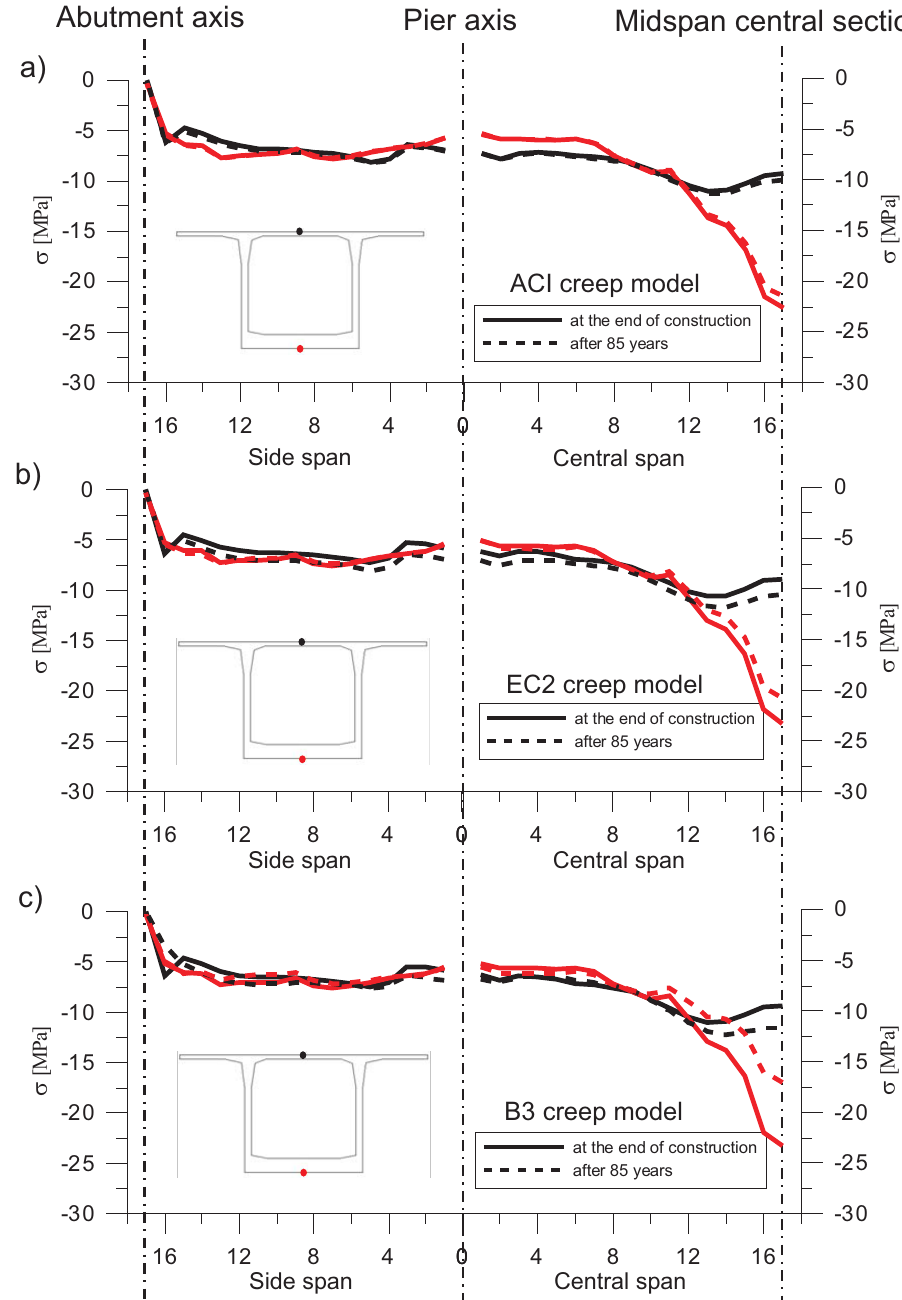
Figure 16. Normal stresses in cross sections between different segments, computed with different creep model: EuroCode2 ( a ), ACI ( b ), and model B3 ( c